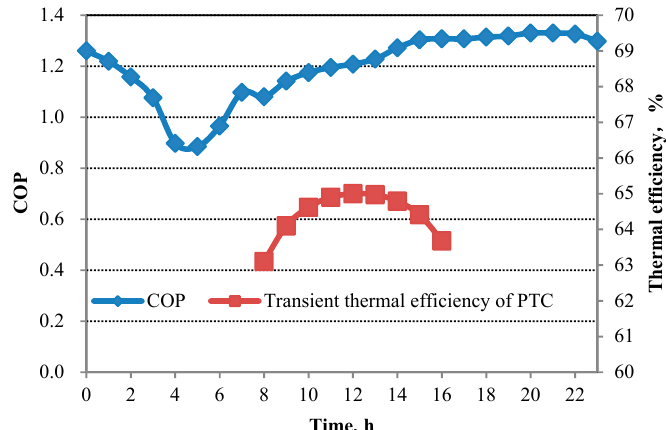
Figure 10. Variations in coefficient of performance (COP) and collecting efficiency of solar collector.